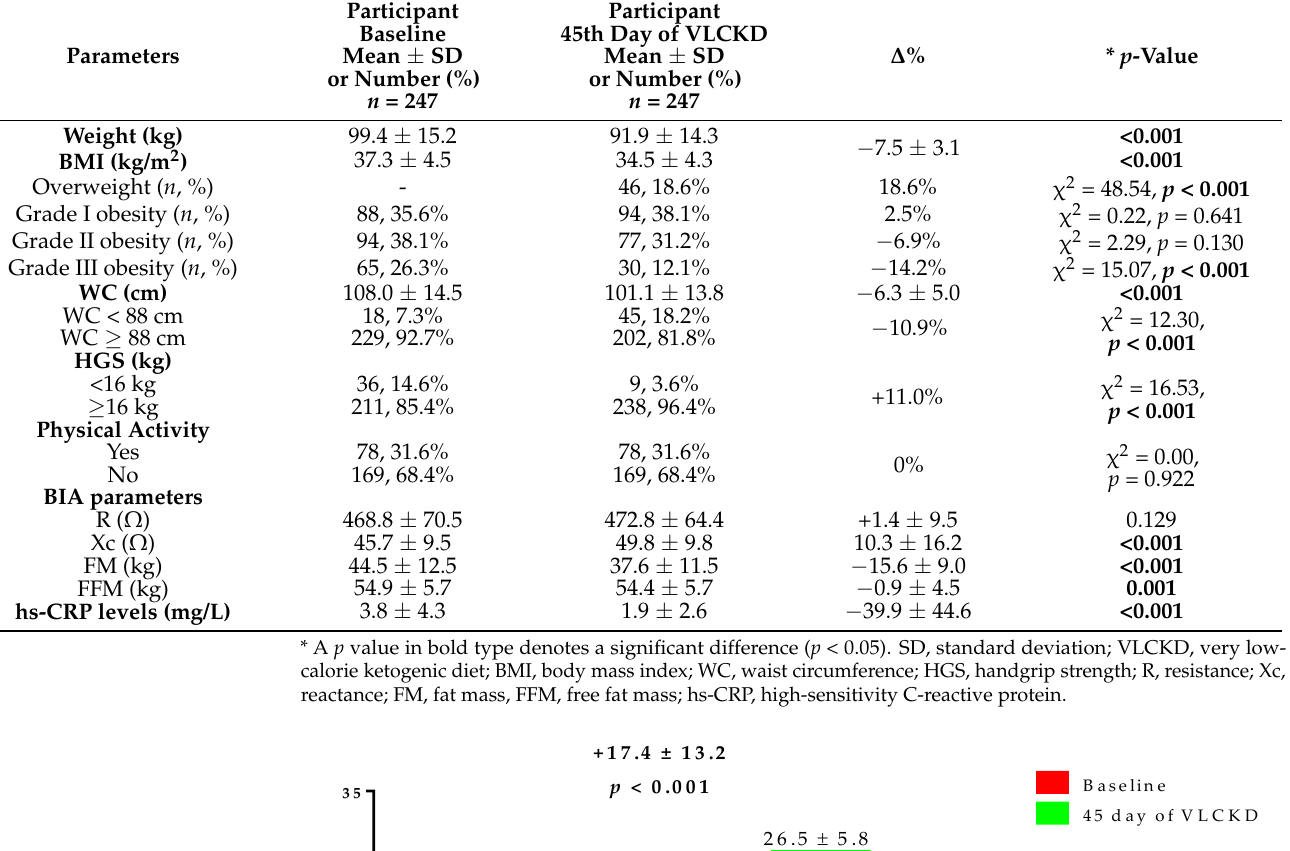
Table 2. Anthropometric measurements, HGS, physical activity, body composition, and inflammatory biomarker of the study population at baseline and after 45 days of the active stage of VLCKD.